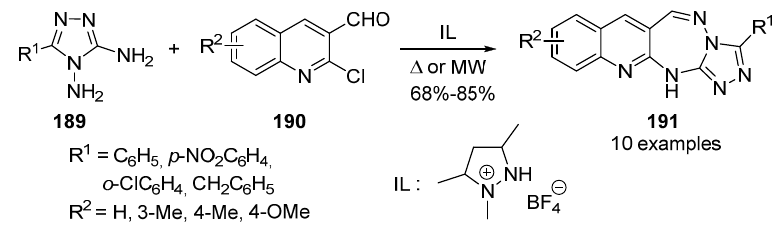
Scheme 37. Green procedure for 1,2,4-triazepine synthesis in ionic liquid as solvent.